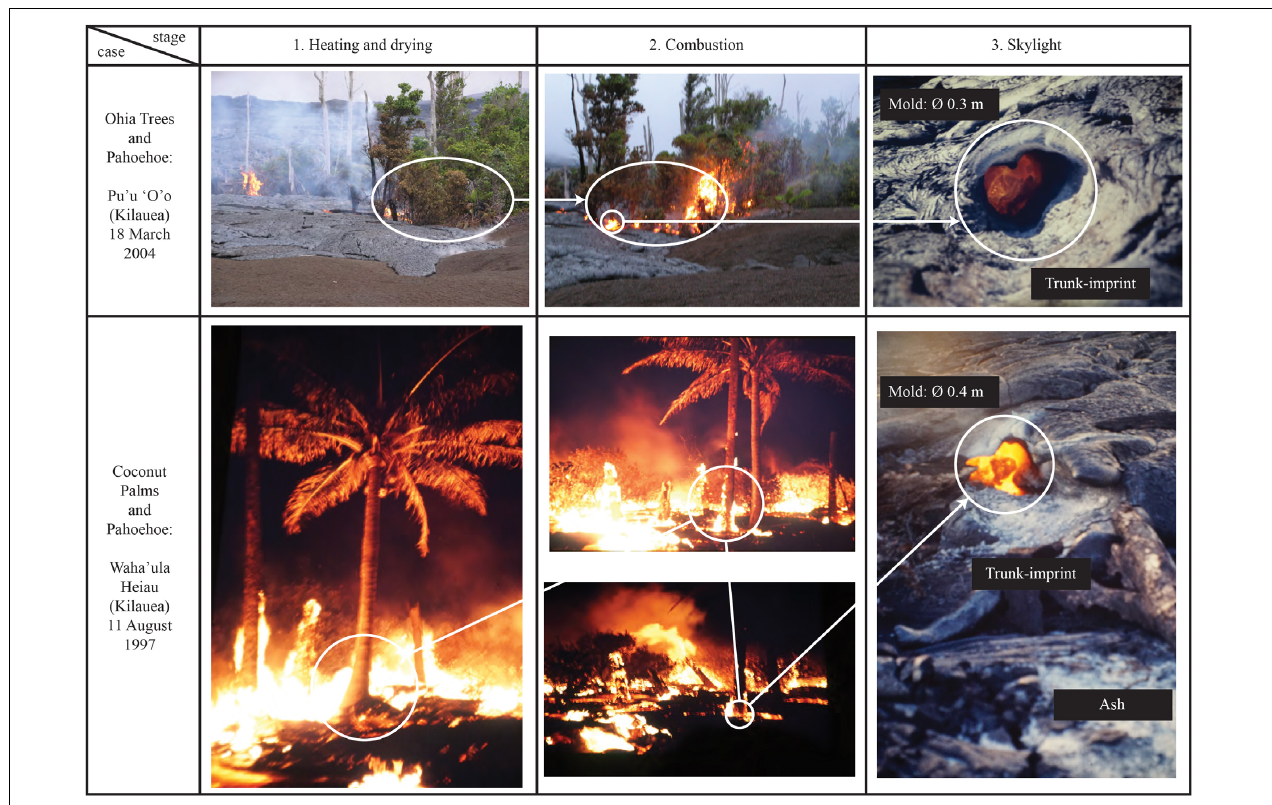
FIGURE 2 | Two examples illustrating the three stages of the thermal model for heat losses involved in tree combustion and mold formation. In the upper example, p¯ahoehoe is moving through a stand of Ohia trees 1.5 km west of Pu’u ‘O’o (Kilauea). For scale, the trunk diameter of the highlighted tree is around 0.3 m. In the lower example, p¯ahoehoe is moving through coconut palms in the (now buried) Waha’ula Heiau site. Situated 120 m from the coast in Kilauea’s Puna district, this was one of Hawaii’s most important temple sites and included a sacred grove (Stokes, 1991), through which lava is here moving. For scale, the trunk diameter of the highlighted tree is around 0.4 m. In column 1 (Stage 1), trees are surrounded by lava, and are undergoing heating and drying, but combustion has not yet begun: no flames are yet apparent on the circled trunk(s). Column 2 includes images at the onset of combustion (Stage 2) where flames are now apparent on the trunks (small circle indicates zone of eventual tree mold site). In Column 3, combustion is complete and an open, incandescent mold remains in the lava representing a skylight of the same diameter as the original tree trunk and through which heat is lost from the interior of the lava during the third and final stage of the lava-tree interaction (stage 3). In both cases, the trunk has fallen onto the flow surface before burning away. P¯ahoehoe inflating around the slow-burning wood lying on the surface has left an imprint of the trunk, which contains unburnt wood and tree